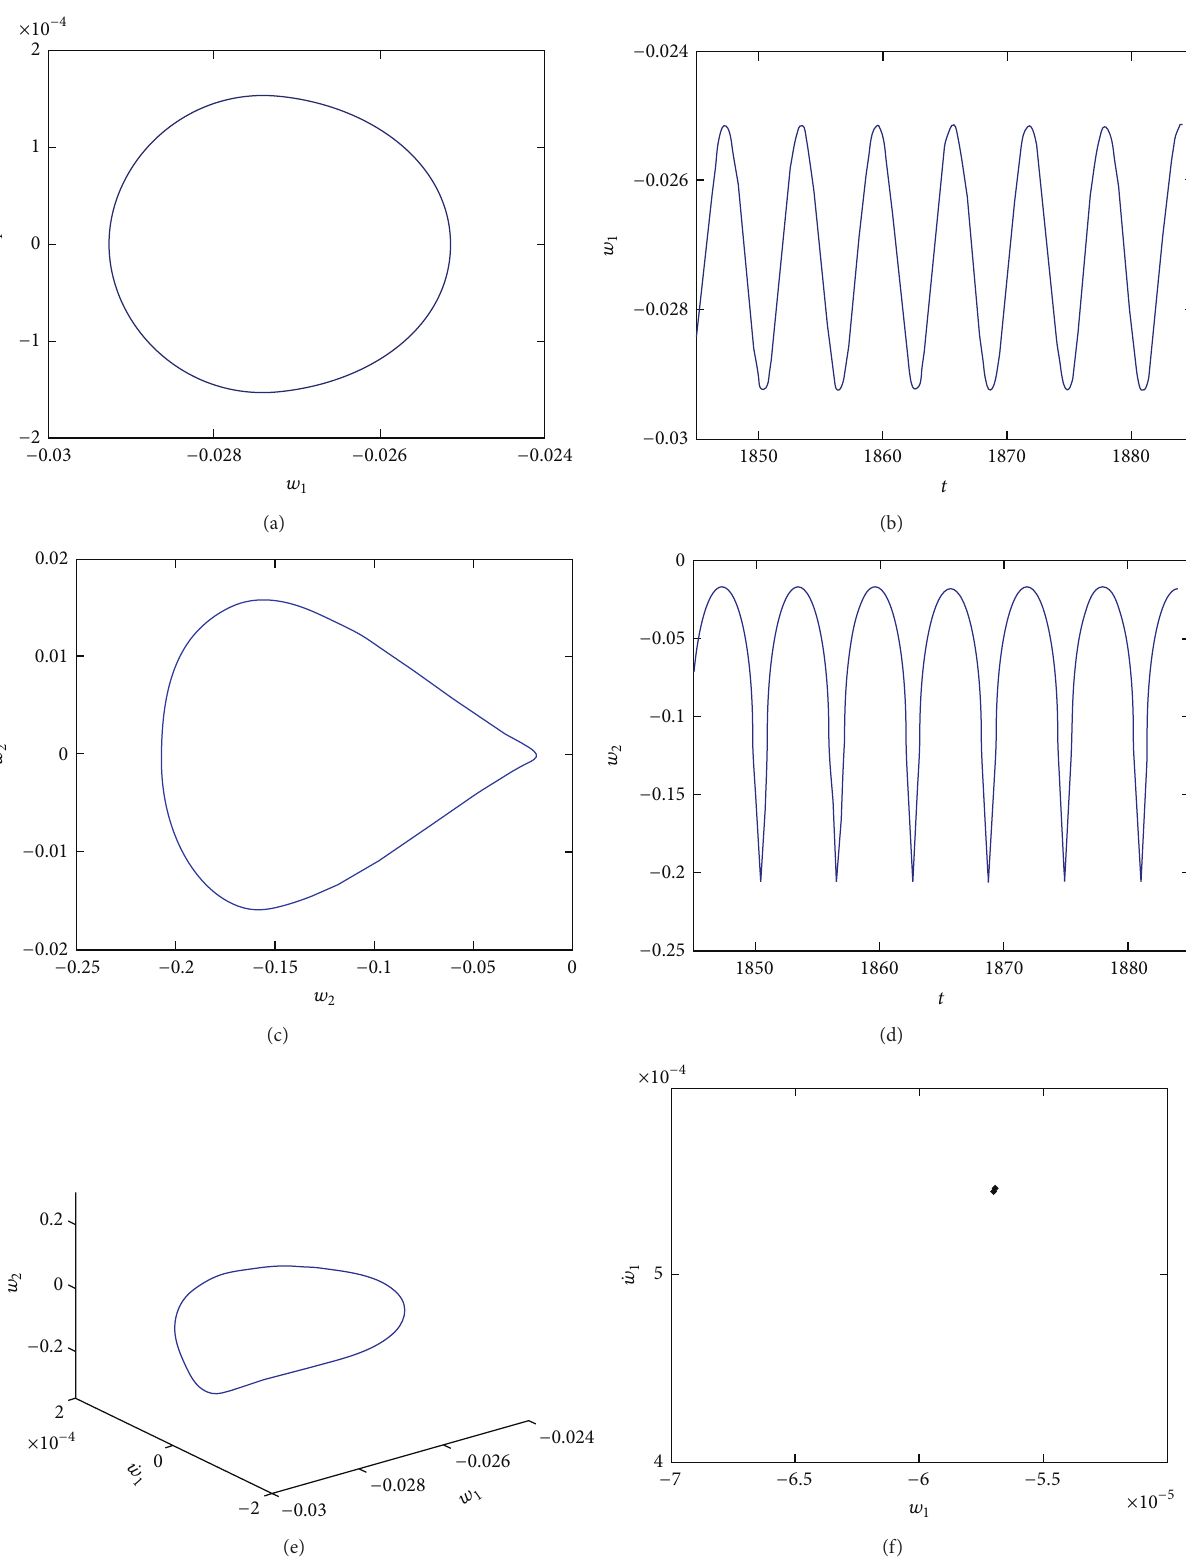
Figure 4: The periodic response of the FGM cylindrical panel occurs when the magnitude of the in-plane excitation is taken to be 5.85×10 7 . The volume fraction index is taken to be 0.5. The Mach number is taken to be 5.0. (a) The phase portrait on plane ( 𝑤 1 , ̇𝑤 1 ); (b) the time response on the planes ( 𝑡,𝑤 1 ); (c) the phase portrait on plane ( 𝑤 2 , ̇𝑤 2 ); (d) the responses on the planes ( 𝑡,𝑤 2 ); (e) three-dimensional phase portrait in space ( 𝑤 1 , ̇𝑤 1 , 𝑤 2 ); (f) the Poincare section on plane ( 𝑤 1 , ̇𝑤 1